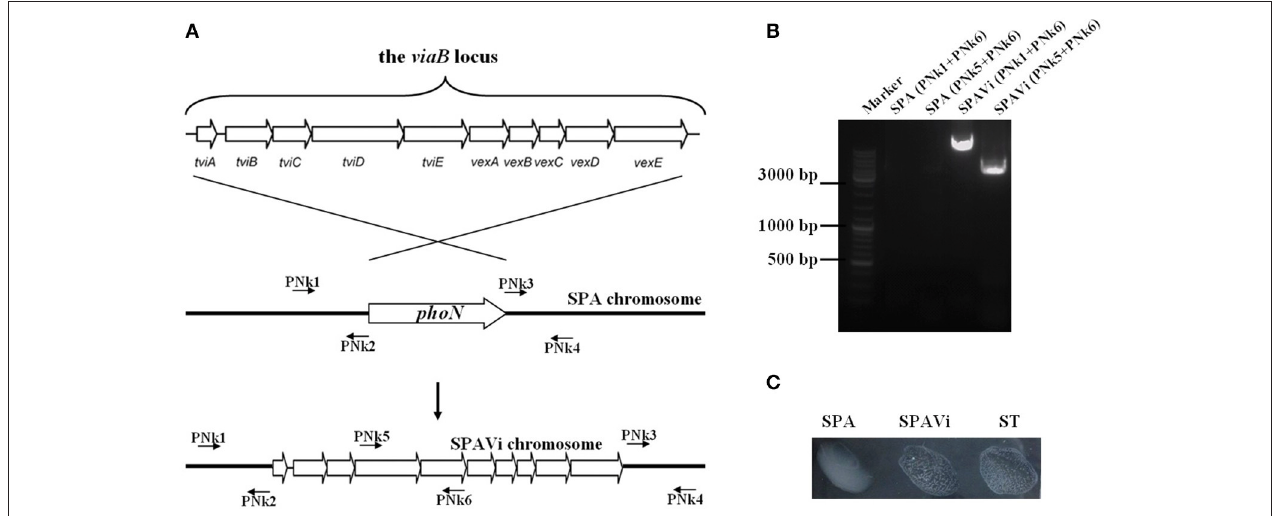
FIGURE 1 | Construction of the viaB -containing Salmonella enterica serovar Paratyphi A strain. (A) Schematic diagram of strain construction. The viaB locus from Salmonella enterica serovar Typhi Ty2 was introduced into the chromosome of S . Paratyphi A by homologous replacement of phoN , a neutral gene of Salmonella . (B) PCR identification of the constructed strain. Relative positions of primers are indicated in schematic diagram. (C) The constructed strain, SPAVi, produces Vi leading to agglutination with Vi-specific antiserum. (SPA is abbreviation for S . Paratyphi A; SPAVi for viaB -containing S . Paratyphi A; ST for S .